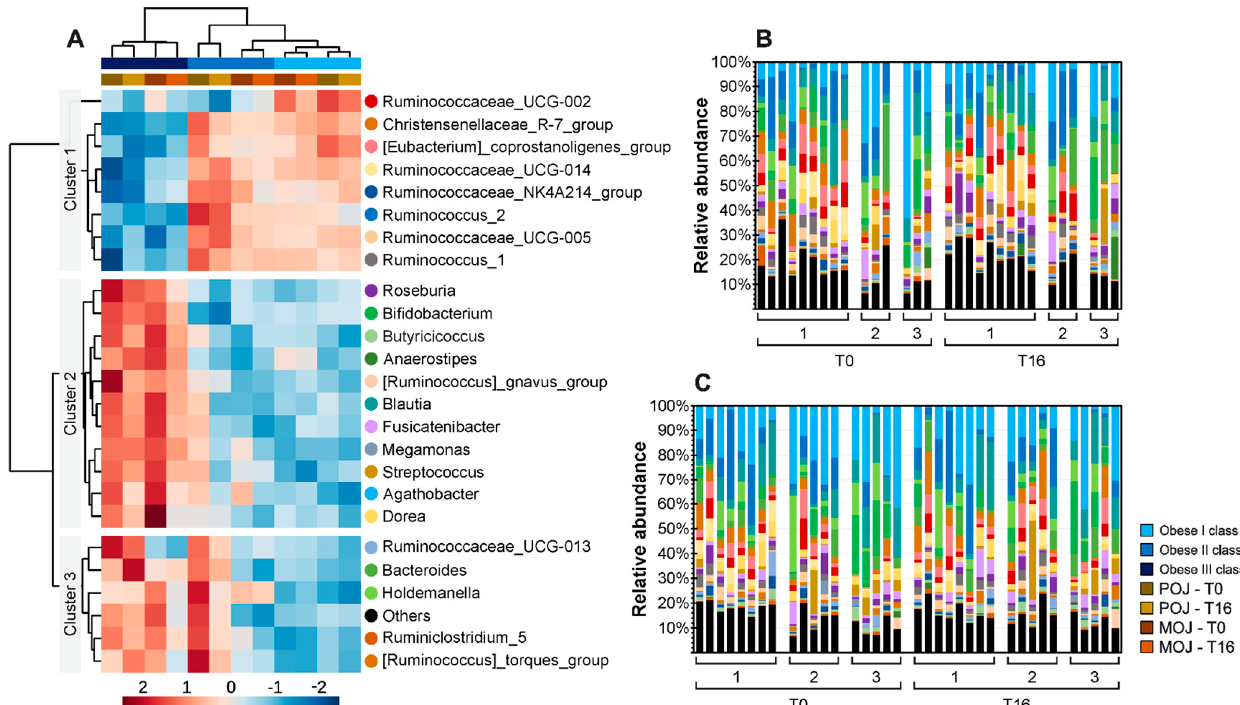
Figure 3. Differential abundance of the top 25 most significant bacterial genera in fecal samples of patients before (T0) and after (T16) the intake of Pera (POJ) and Moro orange juice (MOJ). ( A ) Heatmap showing the gut microbiota genera that were differentially abundant among obesity classes. Rows (genera) and columns (samples) were ordered by hierarchical clustering. ( B , C ) Stacked bar plot showing the relative abundance of microbial genera uncovered in each sample, sorted by obesity class, before (T0) and after (T16) POJ ( B ) or MOJ ( C ) intake. For clarity, genera with an overall abundance of less than 0.5% were summed into “others” (sample sizes in POJ intervention: obesity class I, n = 9; obesity class II, n = 3; obesity class III, n = 3; sample sizes in MOJ intervention: obesity class I, n = 8; obesity class II, n = 5; obesity class III, n = 5).